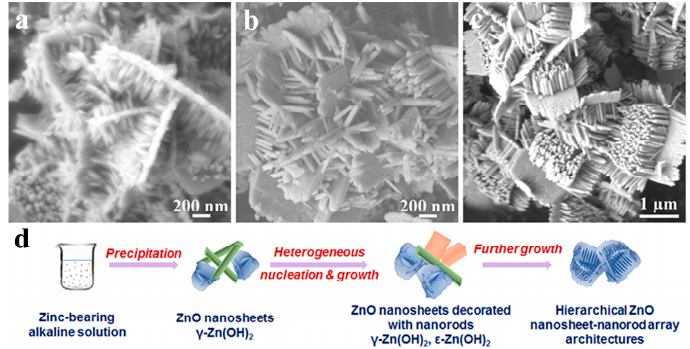
Figure 3. ( a – c ) Morphology evolution of products. ( d ) Schematic illustration for the metastable phase-directed formation mechanism of hierarchical ZnO nanosheets-nanorods (Reproduced with permission from [41], Copyright 2016, American Chemical